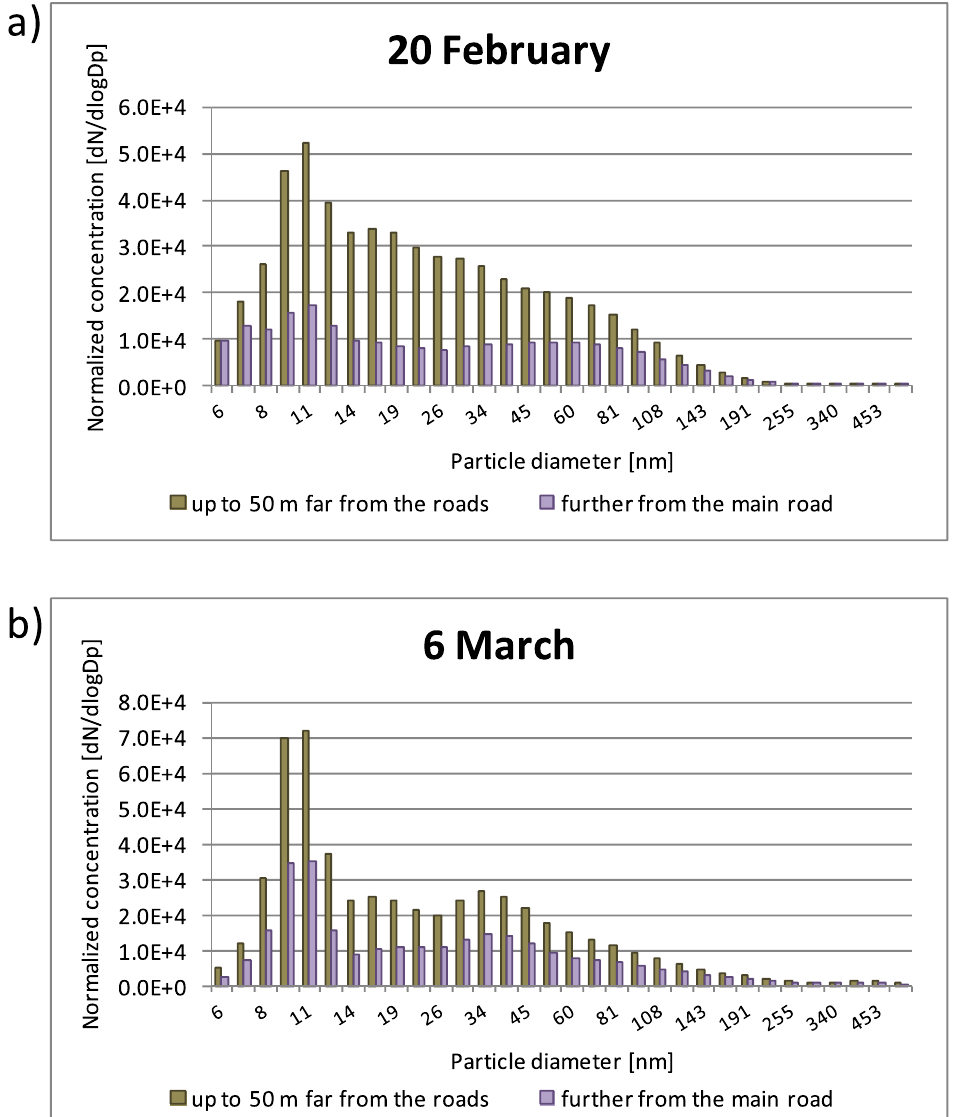
Figure 6. Particle number distribution measured in Sporilov on 20 February ( a ) and 6 March ( b ) according to distance from the main road. The highest peaks for both measurements were observed in 10 nm diameter particles, the second smaller peaks were formed in 20 and 40 nm particles for 20 February and 6 March, respectively. Similarity in distributions near and away from the main roadways and relative shift of smaller particles to larger ones in places further from the main roadways in comparison with places near the roadways indicated that particles measured deeper in a housing estate had a traffic